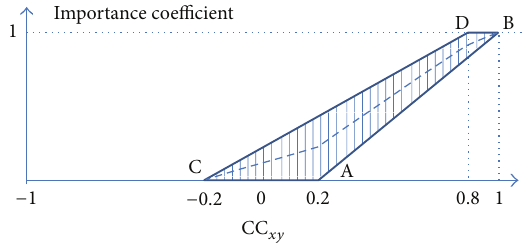
Figure 3: Conversion from correlation coefficient to importance